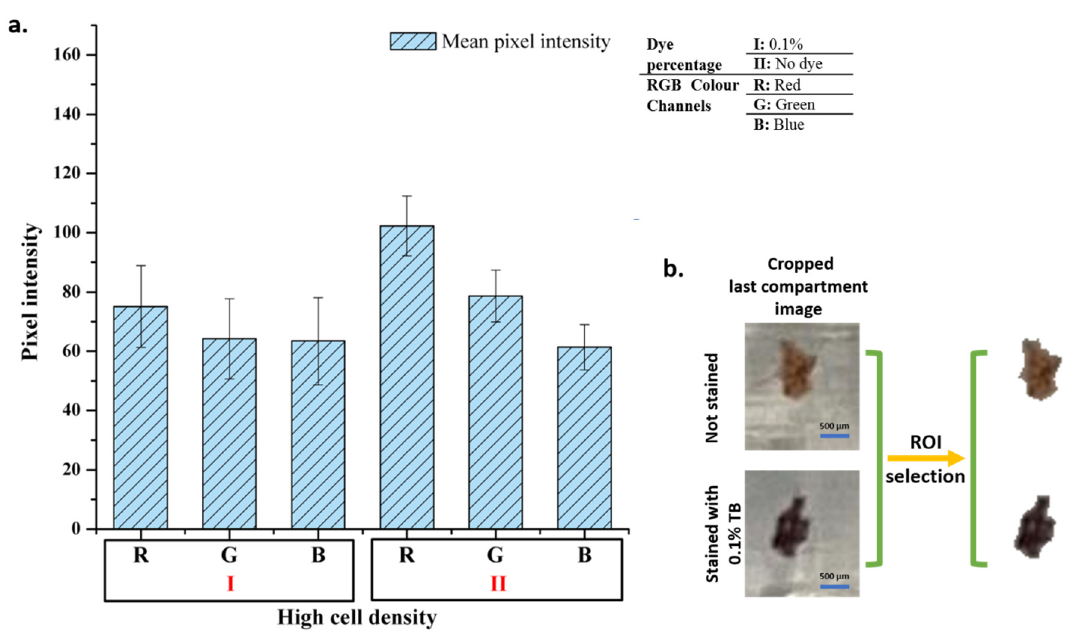
Figure 7. Mobile phone image analysis. Pixel intensity analysis results of the images ( a ) and image processing step ( b ) .